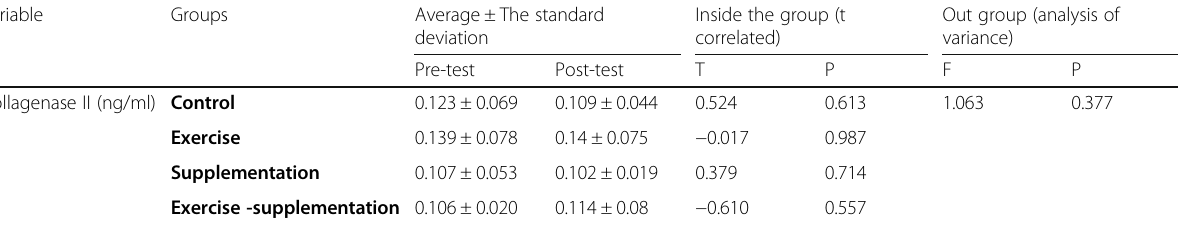
Table 2 Correlation between t-test and analysis of variance of synovial collagenase-2 levels in post-test and pre-test groups Variable